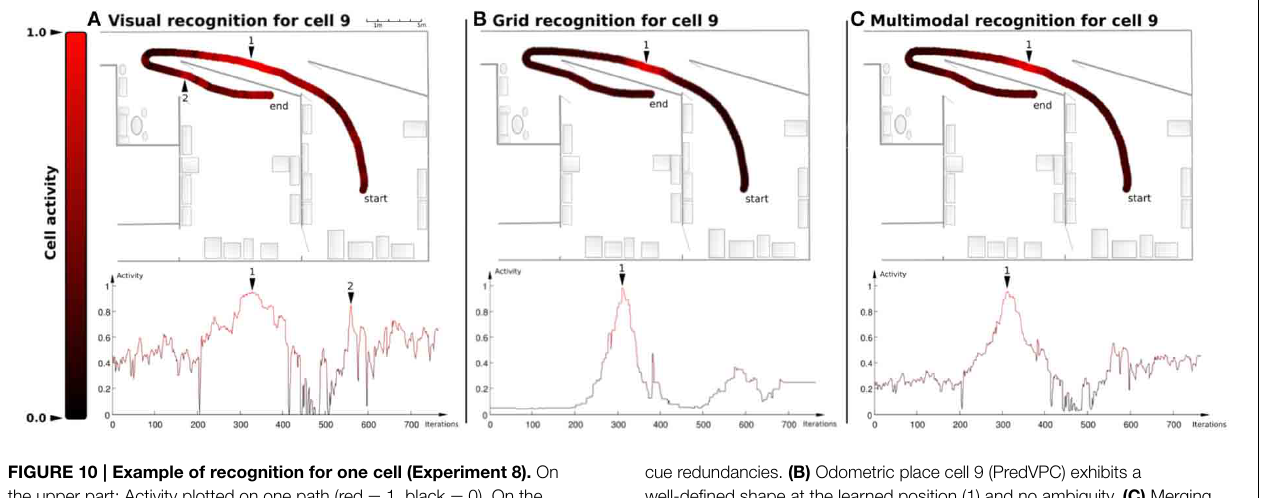
cue redundancies. (B) Odometric place cell 9 (PredVPC) exhibits a well-defined shape at the learned position (1) and no ambiguity. (C) Merging the 2 allows the system to disambiguate vision. Results present a correct activity for the multimodal place cell (MPC) 9.